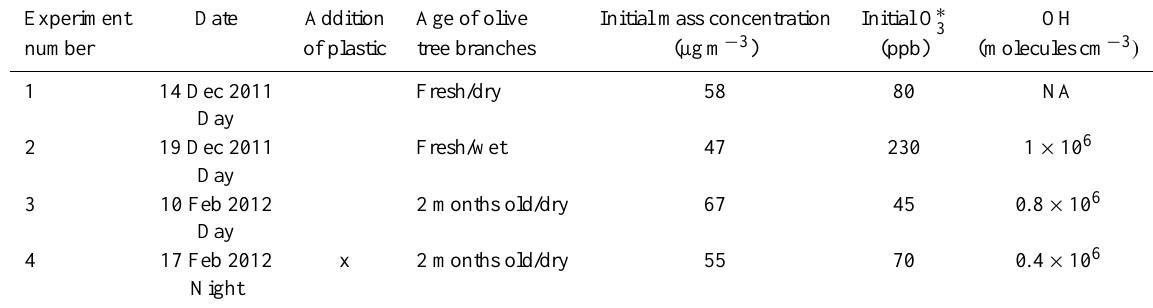
Table 1. Conditions for chamber